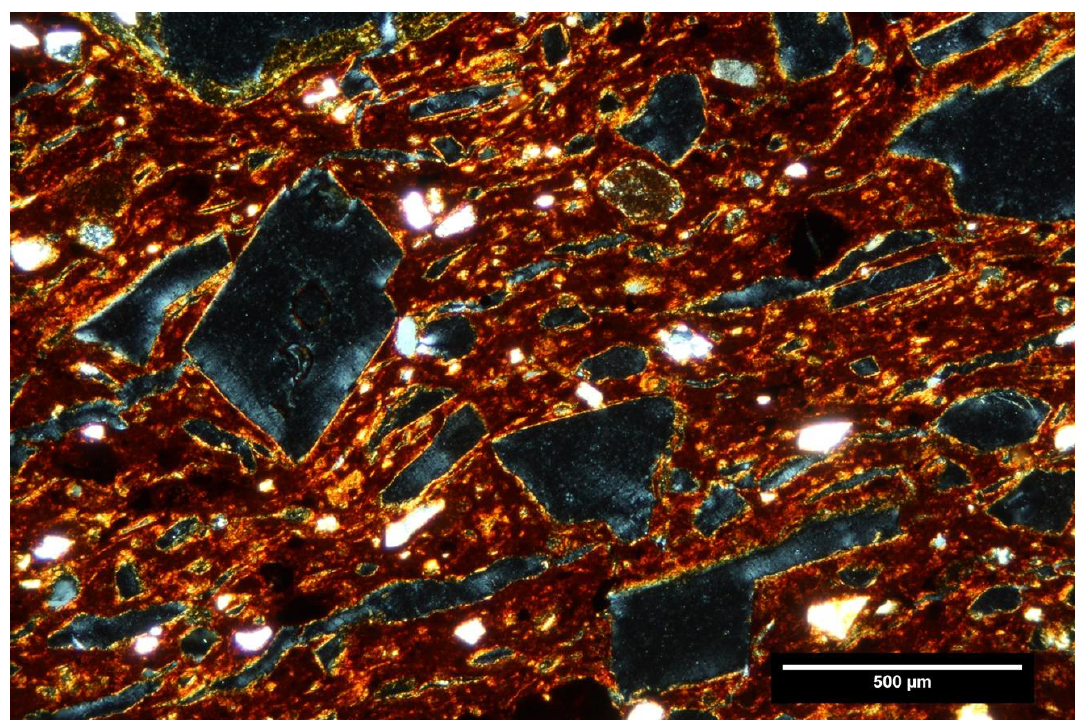
Figure 7. Photomicrograph of eroded calcite grain voids or calcite ghost voids in sample M40 from fabric C-1 that have calcareous material deposited around the edges of the pores. It is practically invisible in the thin section, except as bright lines of high birefringence around the pores. Photomicrograph taken under crossed-polars by Jennifer Meanwell.